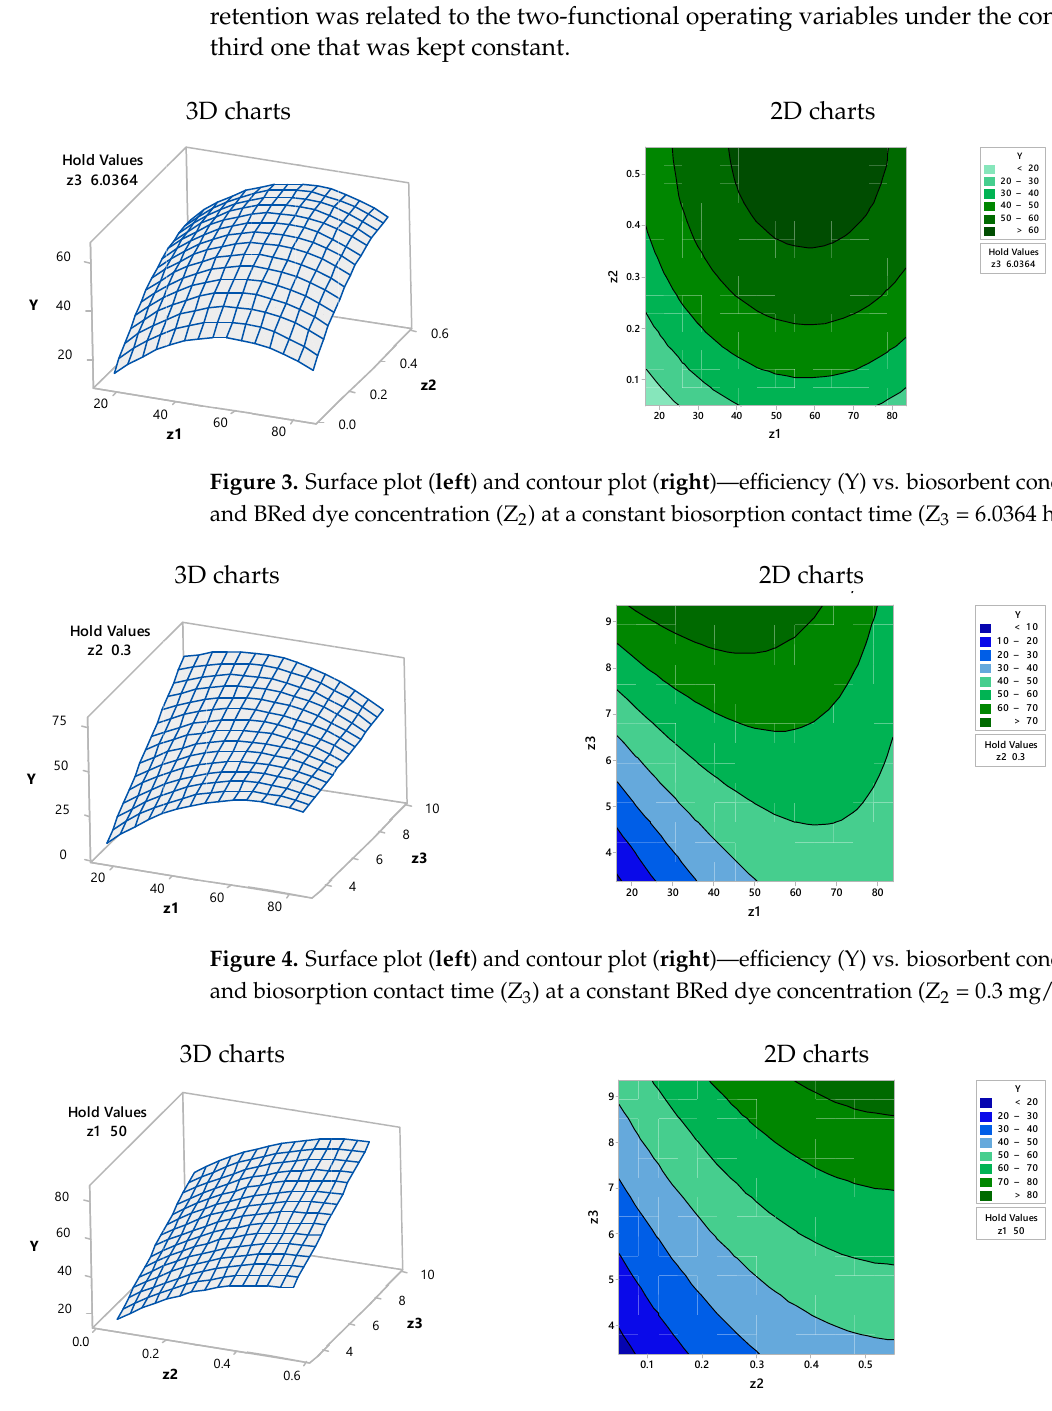
Figure 5. Surface plot ( left ) and contour plot ( right )—efficiency (Y) vs. BRed dye concentration (Z 2 ) and biosorption contact time (Z 3 ) at a constant biosorbent concentration (Z 1 = 50 g/L).